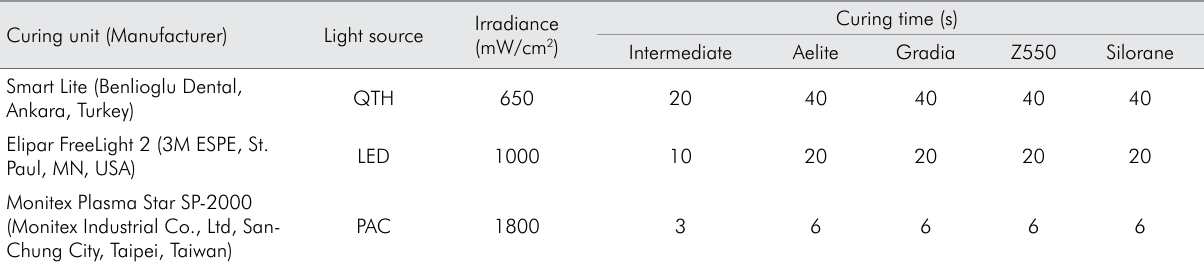
Table 2. Light-Curing Units and Curing Times Used in the Current Study. Curing unit (Manufacturer)